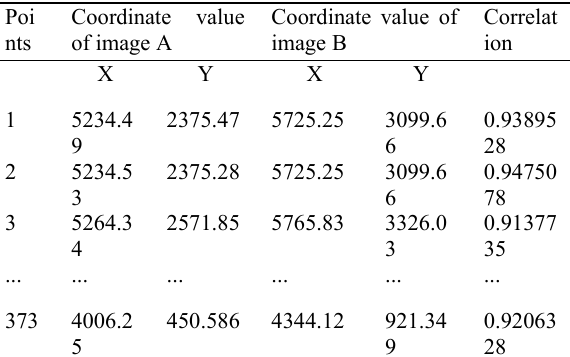
Table 3. Correlation between coordinate points of two images